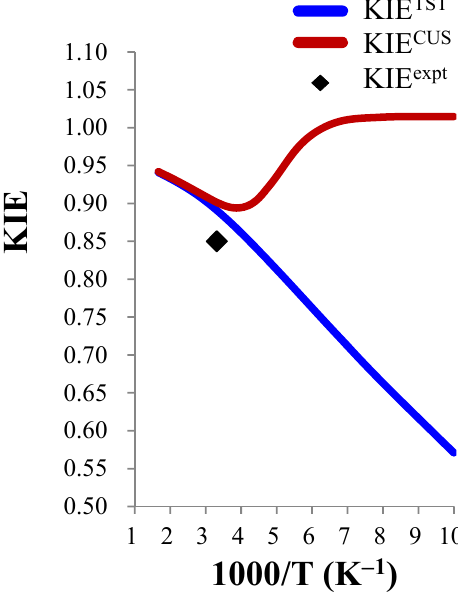
Figure 1. Temperature dependence of the calculated deuterium KIEs of the gas phase ClO − Cl reaction using the TST and CUS methods. + CH 3